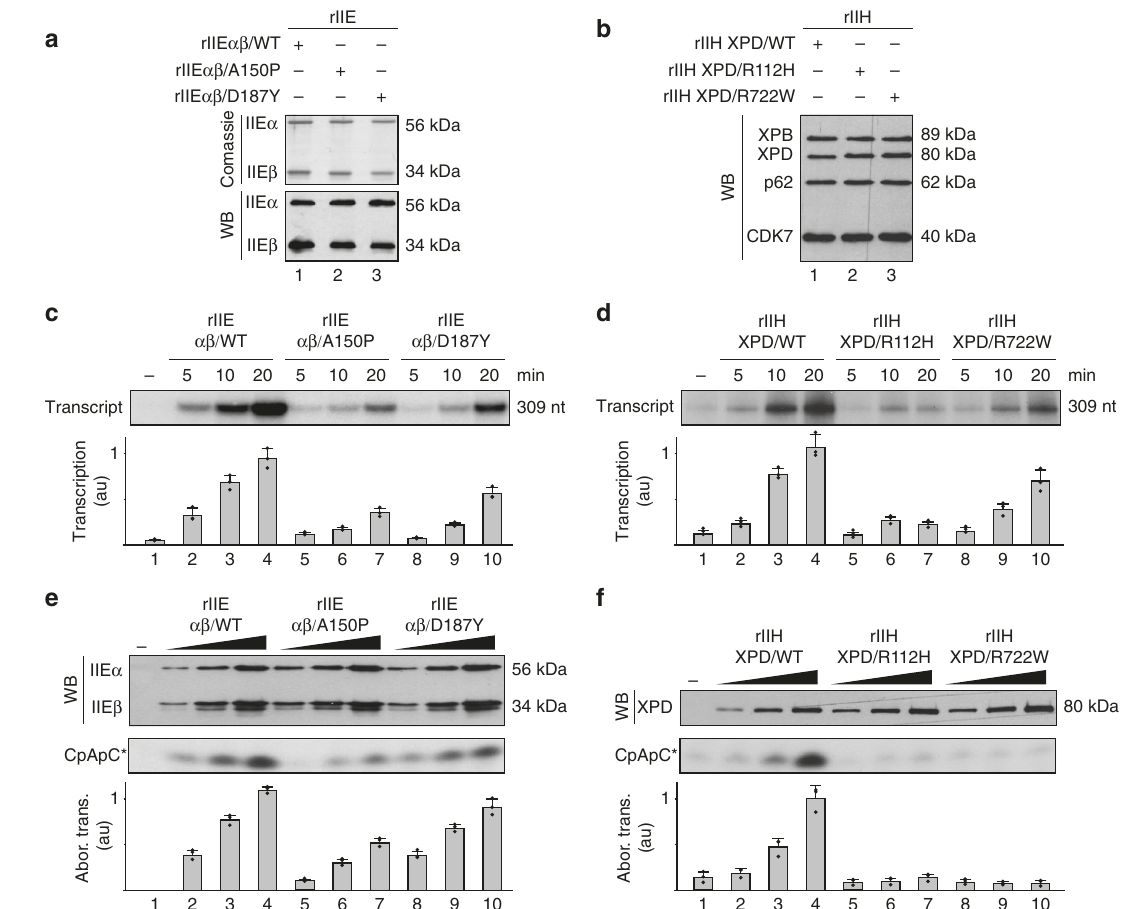
Fig. 2 Defective TFIIE and TFIIH affect transcription initiation. a Production of the recombinant mutated forms of TFIIE (rIIE). Equal amounts of puri fi ed rIIE were resolved by SDS – PAGE. Coomassie blue staining gel (top panel) and western blot (WB, bottom panel) with antibodies raised against TFIIE α and TFIIE β are shown. b Production of the recombinant mutated forms of TFIIH (rIIH). Equal amounts of puri fi ed rIIHs were resolved by SDS – PAGE and immunoblotted for XPB, XPD, p62, and CDK7. c , d Puri fi ed rIIEs ( c ) and rIIHs ( d ) were added to in vitro reconstituted transcription systems, as indicated. After addition of NTPs (including radiolabelled CTP), the transcription activity was assessed after 5, 10, and 20 min of incubation. The length of the corresponding transcript (309nt) is indicated on the right side. The signals were quanti fi ed ( n = 3, means ± s.d.) and plotted in arbitrary units (a.u.). The results are representative of three independent experiments. e , f Abortive transcription assays using rIIEs ( e ) and rIIHs ( f ). After preinitiation complex assembly using equivalent amounts of the different puri fi ed rIIEs and rIIHs (as revealed by western blots), phosphodiester bond synthesis was initiated by the addition of priming dinucleotides CpA and radiolabelled CTP. After 30 min of incubation, the radioactive trinucleotide (CpApC*) synthesis was stopped, quanti fi ed ( n = 3, means ± s.d.) and plotted in arbitrary units (a.u.). The results are representative of two independent experiments. Source